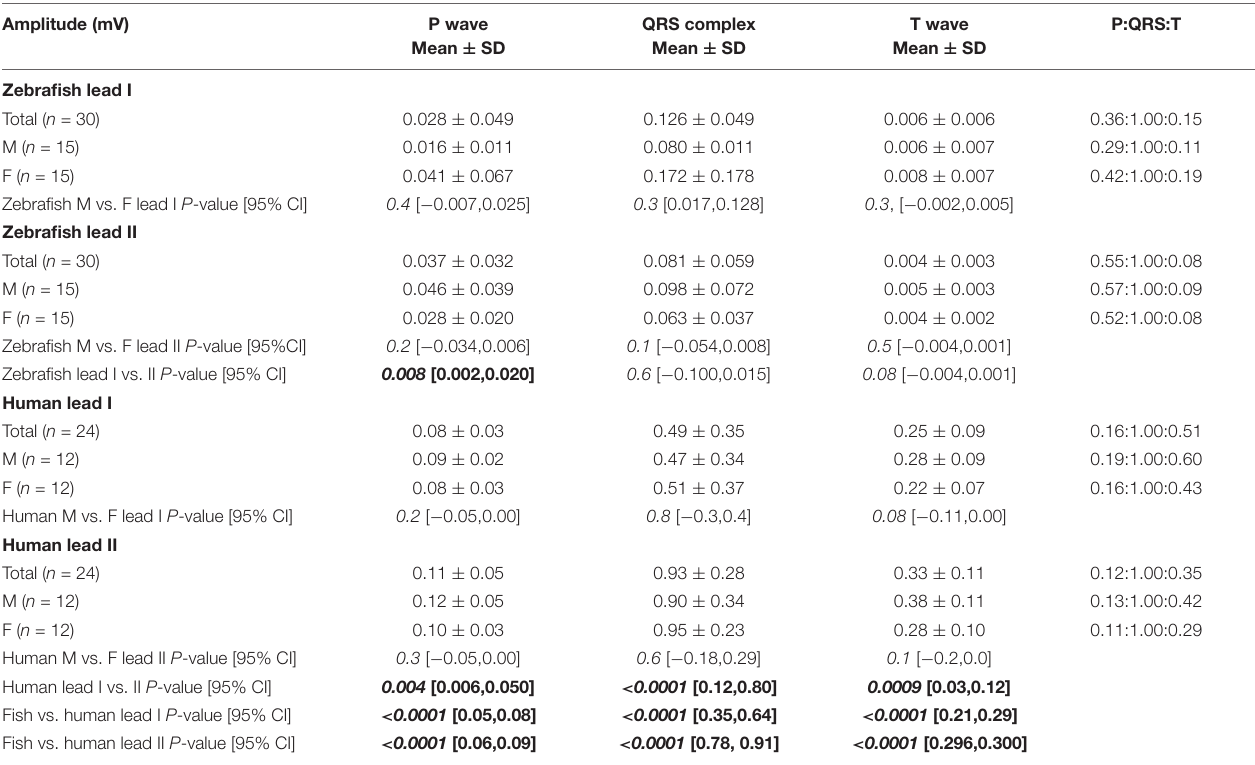
TABLE 2 | Amplitude of ECG components on Einthoven leads in zebrafish vs. humans. Amplitude (mV) P wave